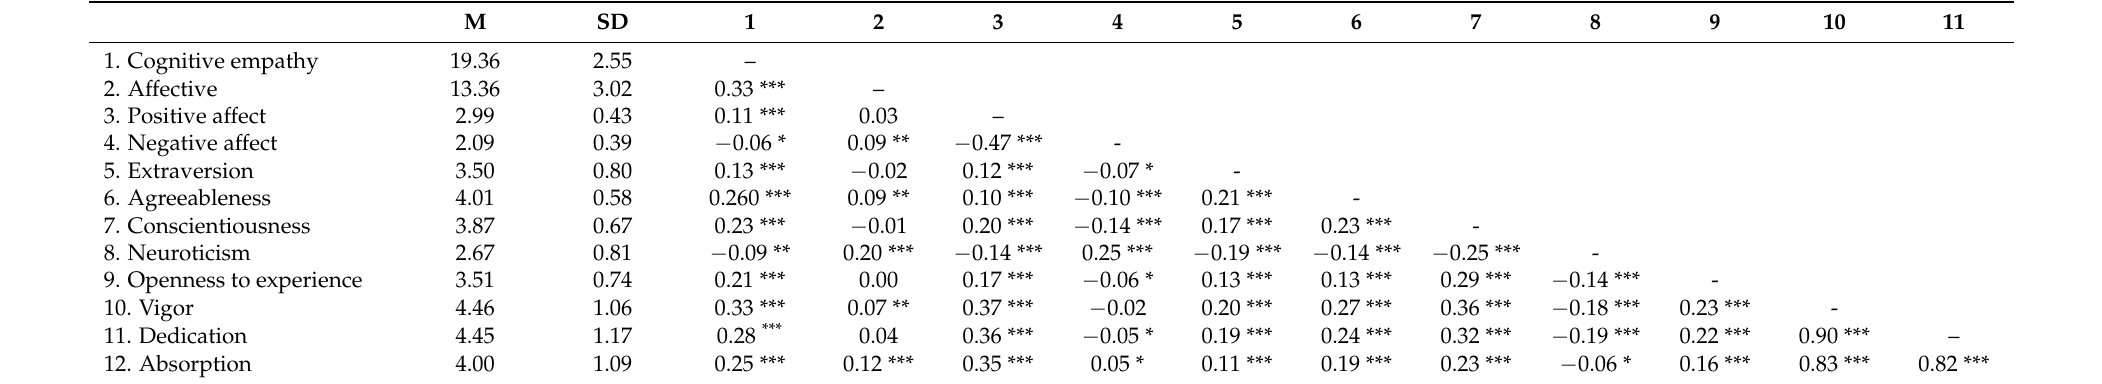
Table 1. Descriptive and correlational statistics: empathy, affect, personality, and engagement ( n =